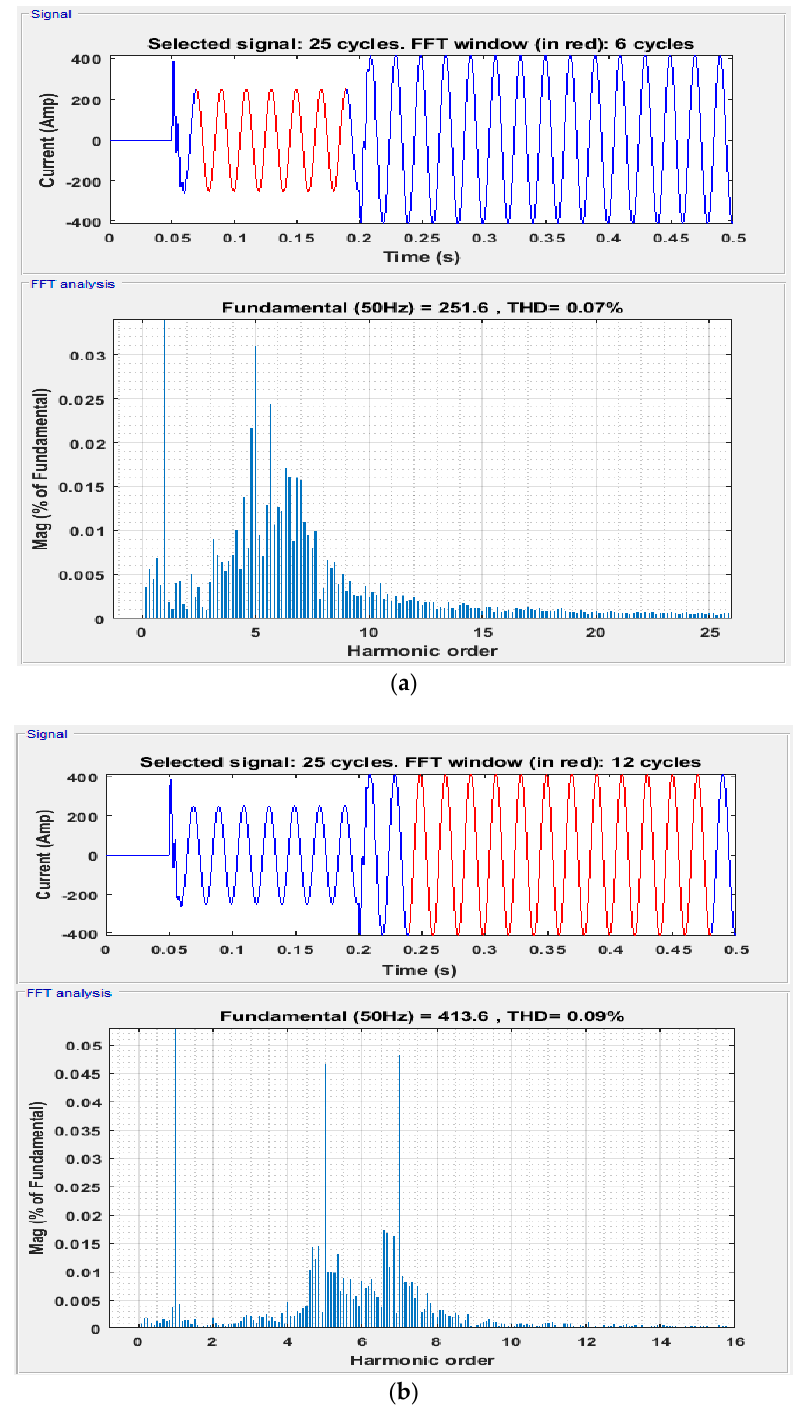
Figure 8. %Total Harmonic Distortion (THD) in output current after ( a ) MG injection and ( b ) load change.